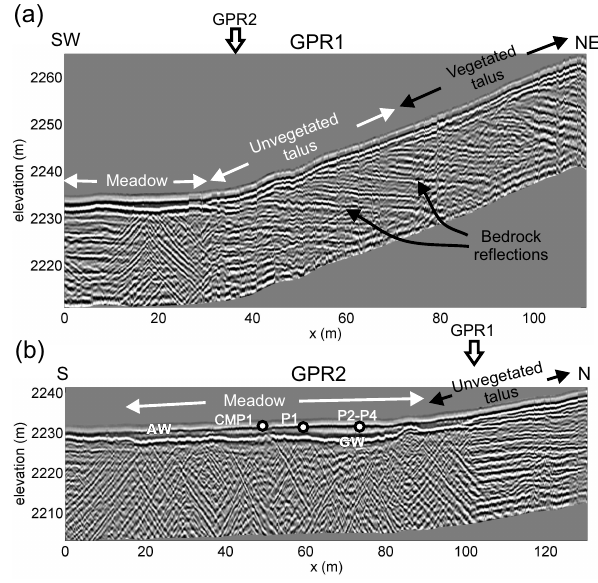
Fig. 4. Processed GPR cross-sections from profiles (a) GPR1 and (b) GPR2. Profile locations are shown in Fig. 3a. Block arrows show where the two lines intersect. Three zones with different sur- face characteristics are demarcated: meadow, unvegetated talus and vegetated talus. The dots in (b) mark the projected locations of the center of the CMP1 GPR profile, piezometer P1 and the cluster of piezometers P2-P4 onto profile GPR2. AW and GW in (b) indicate the airwave and groundwave phases,